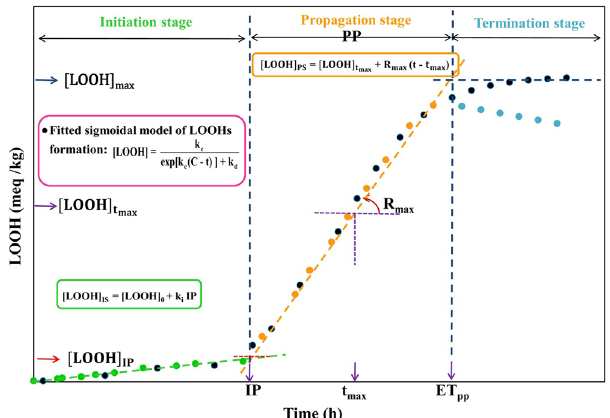
Figure 1. Schematic curve of lipid hydroperoxides (LOOHs) production and a guide of calculated kinetic parameters. IP induction period, PP duration of the propagation stage, ET pp end time of propagation stage, ki pseudo-zero order rate constant at the initiation stage, k c pseudo-first order rate constant of LOOHs formation at the propagation stage, k d pseudo-second order rate constant of LOOHs decomposition at the propagation stage, R max maximum rate of LOOHs formation in the propagation stage, [ LOOH ] 0 LOOH concentration at t = 0, [ LOOH ] IP LOOHs concentration at IP point, [ LOOH ] Tmax LOOHs concentration at the point of the maximum rate of LOOHs formation, [ LOOH ] max maximum concentration of produced LOOHs, T max occurrence time of maximum rate of LOOHs formation, C integration constant 20